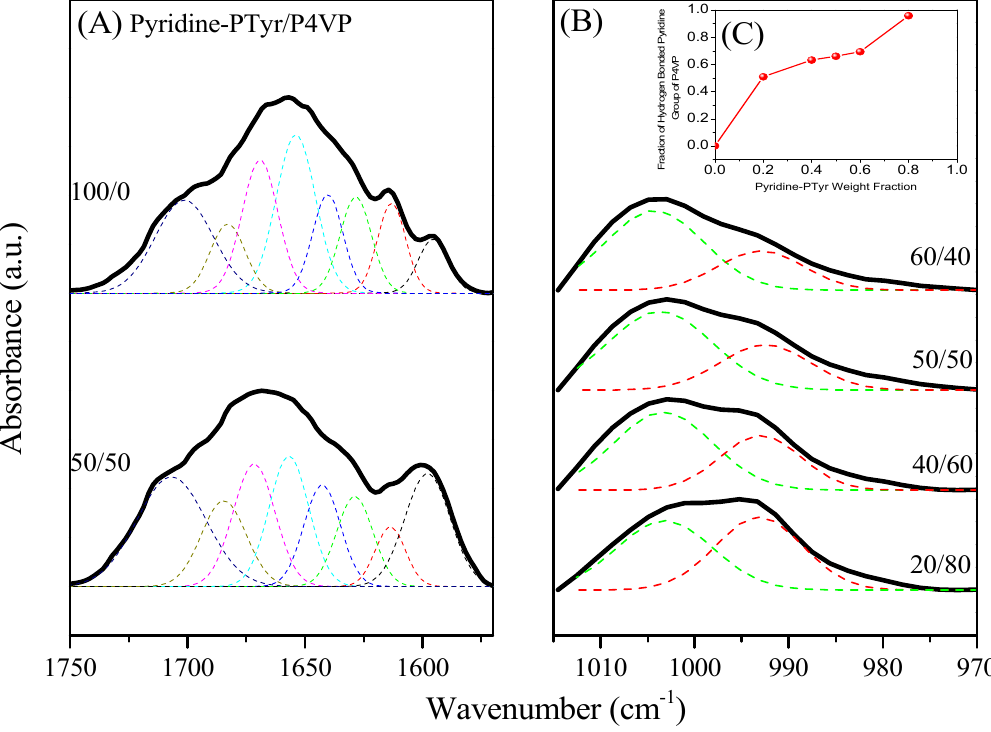
Figure 11. Curve fitting of the data in Figure 10 for the miscible PTyr-TPA/P4VP blends for the: ( A ) amide I absorption; ( B ) pyridine unit absorption; and ( C ) fraction of hydrogen-bonded pyridine units upon increasing the content of PTyr-TPA.